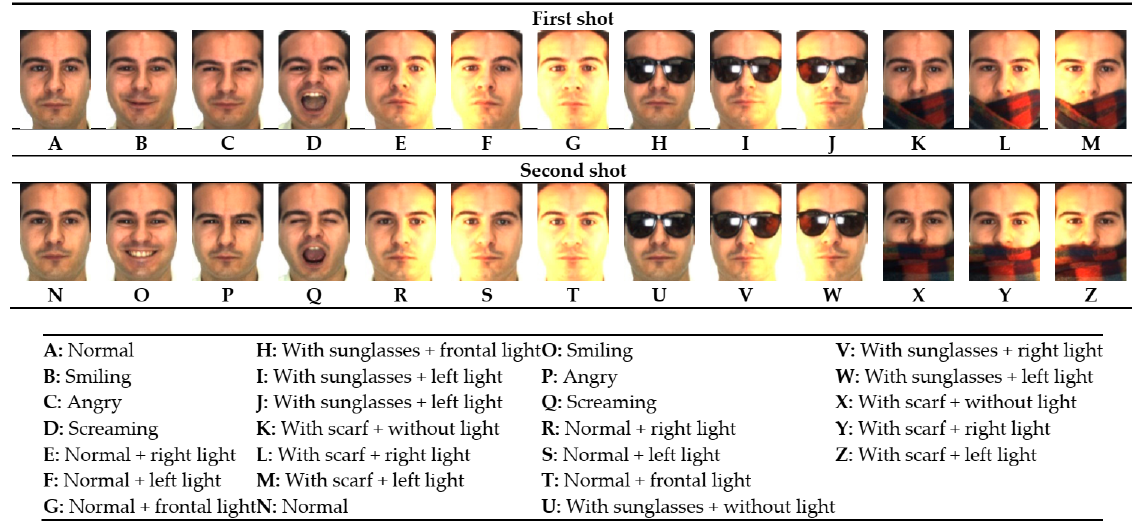
Figure 6. The 26 facial images of the first individual from the AR database and their detailed